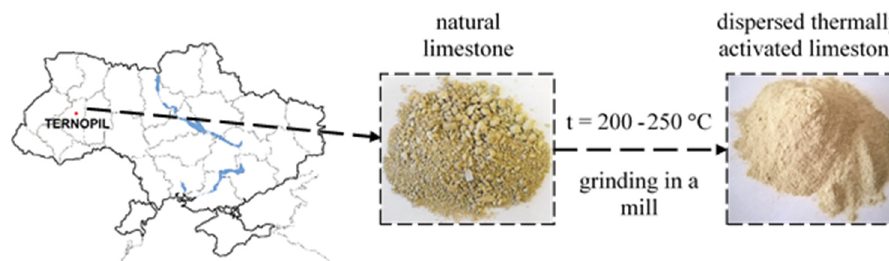
Figure 1. The object of the laboratory studies.